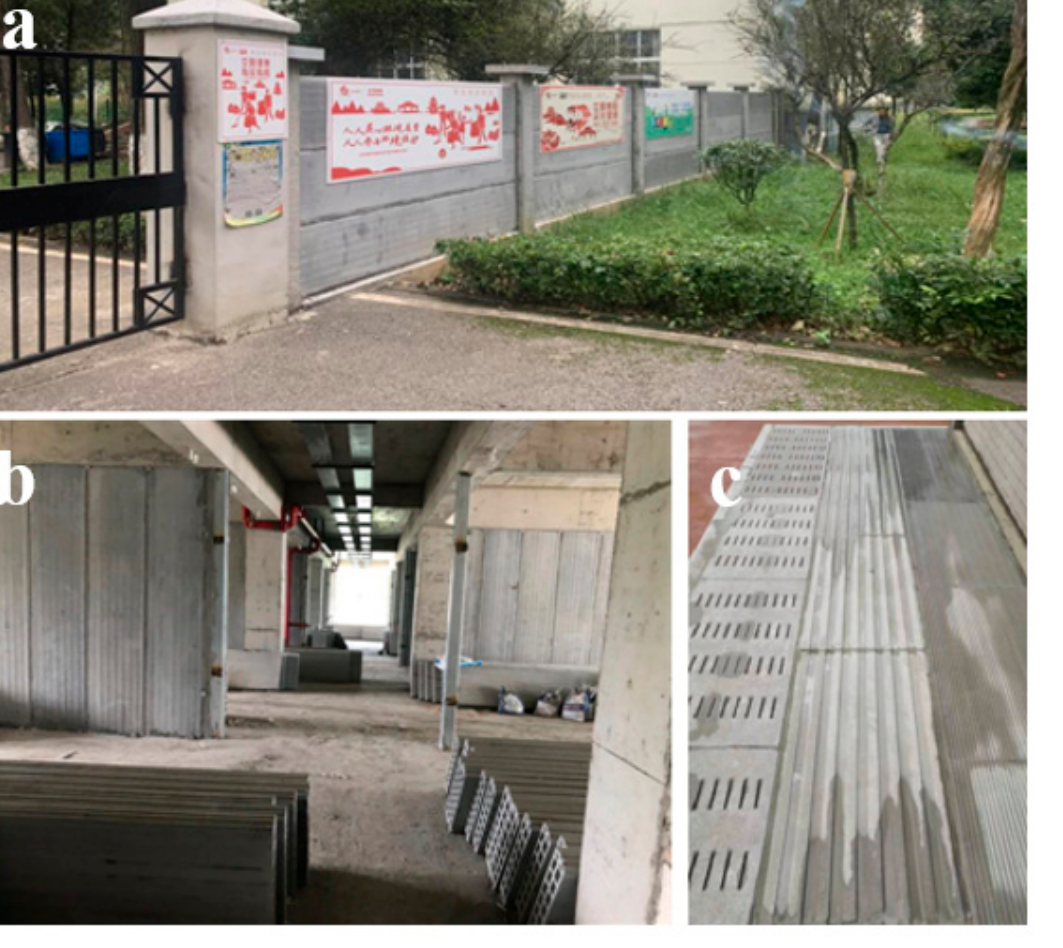
Figure 10. ( a ) PG exterior wall in the campus of Guizhou Institute of Technology produced from HPG-E composites; ( b ) PG interior wall panel produced from HPG-E composites; ( c ) PG pavement produced from HPG-E composites.